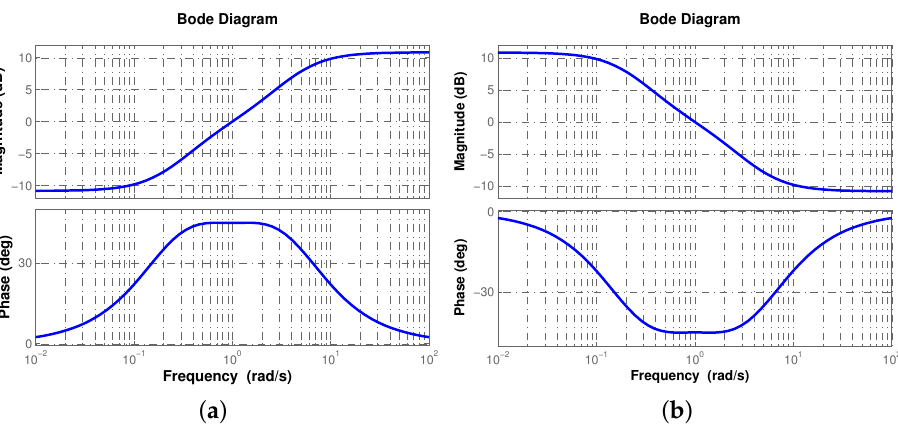
Figure 2. Frequency response of s ± 0.5 , where arg { T ( j 1 ) } = ± απ /2 = ± 45 ◦ for both ( a ) derivative and ( b ) integral effect of